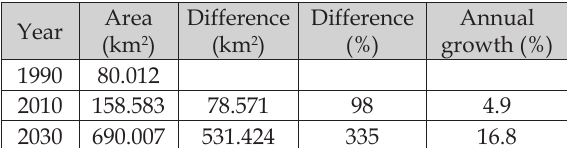
Table 2. Urban growth of Makkah city between 1990 and